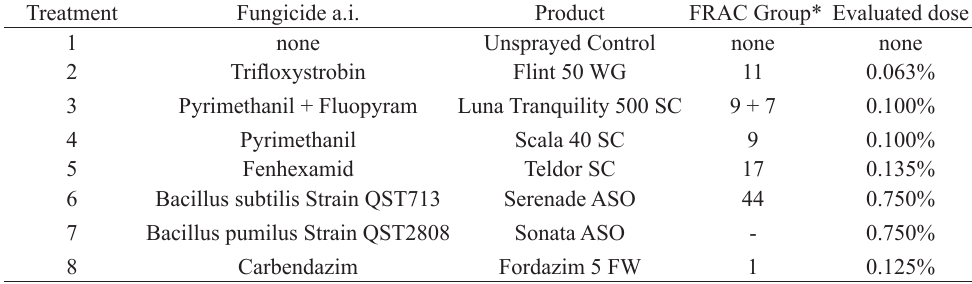
Table 1. Fungicides evaluated for the control of Botrytis cinerea in the laboratory and field phase